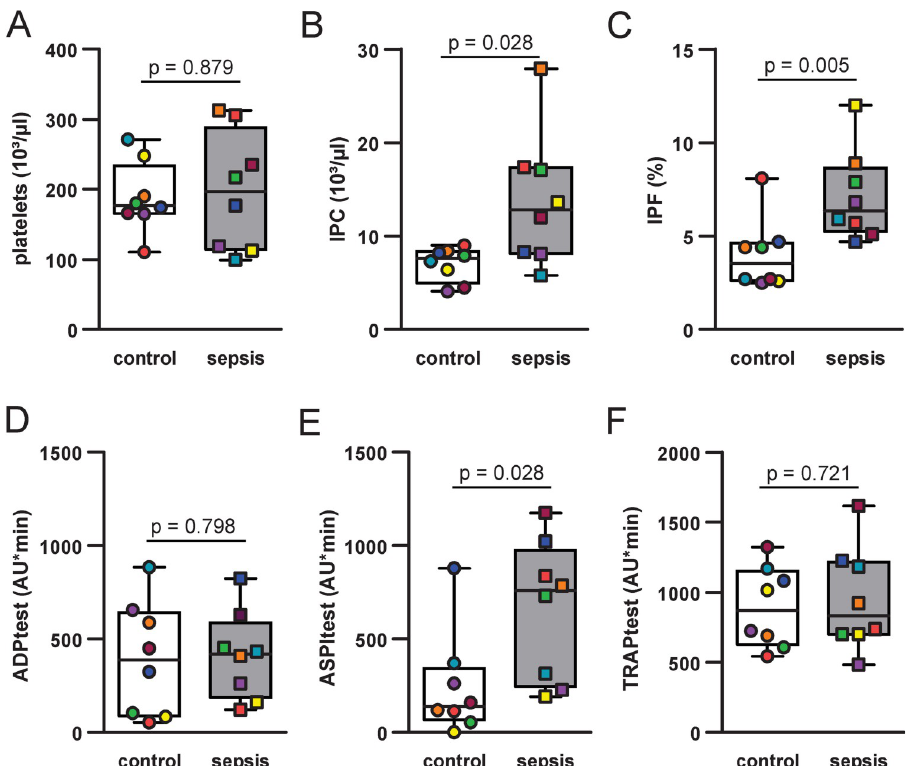
Fig 1. Platelet parameters and platelet reactivity. Comparison between control patients (transparent bars) and patients with sepsis (filled bars) in A-F. Platelet counts (A), immature platelet count [IPF] (B) and immature platelet fraction [IPF] (C) in upper row. Multiplate aggregometry with stimulation by adenosine diphosphate at a final concentration of 6.5 µ M [ADPtest] (D), by arachidonic acid at a final concentration of 0.5 mM [ASPItest] (E) and by thrombin-receptor associated protein 6 at a final concentration of 32 µ M [TRAPtest] (F) in lower row. Filling colour of data points indicates individual samples within the respective groups, boxes with inner line display interquartile range with median, whiskers minimum and maximum of values. P values from Mann-Whitney U